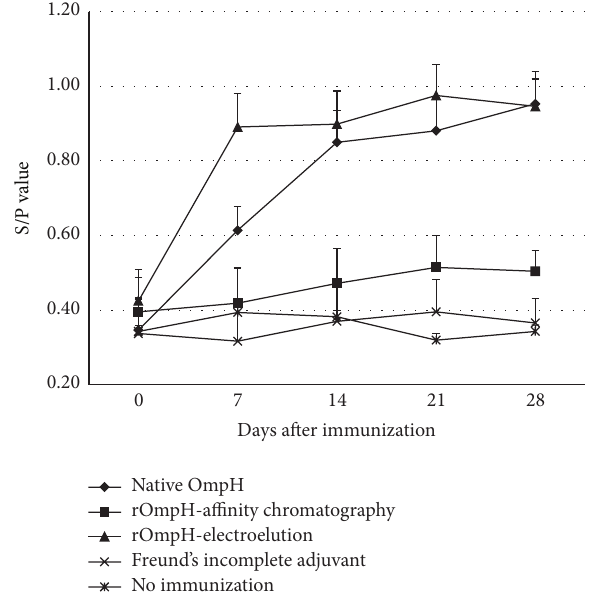
Figure 3: The temporal pattern of the average S/P value of chicken sera (including standard error) based on indirect ELISA (ProFLOK) for each of the five treatment groups (first vaccination on day 0 and the second on day 14).